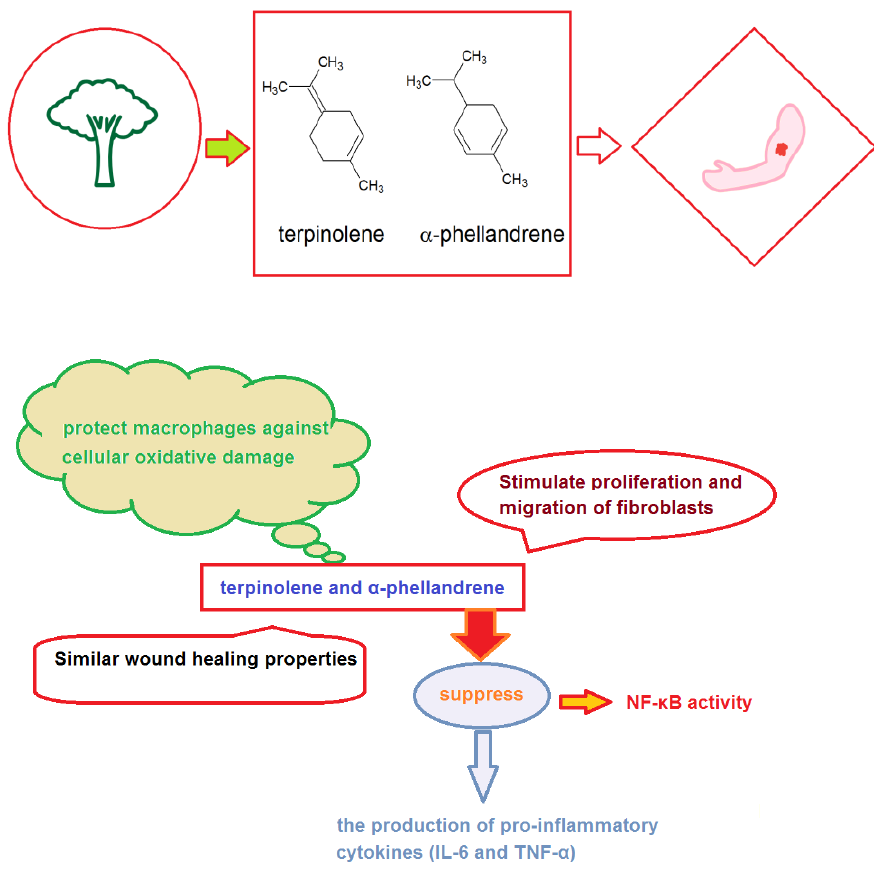
Figure 2. Some plant-produced volatile organic compounds involved in wound healing and their biomolecular mechanism.